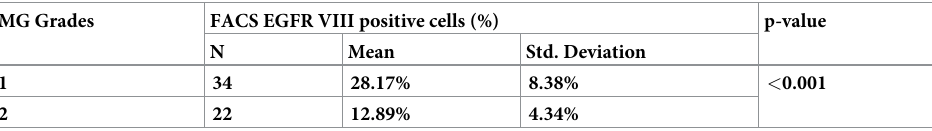
Table 4. Expression of FACS EGFR VIII positive cells (%) in meningioma grade I and II